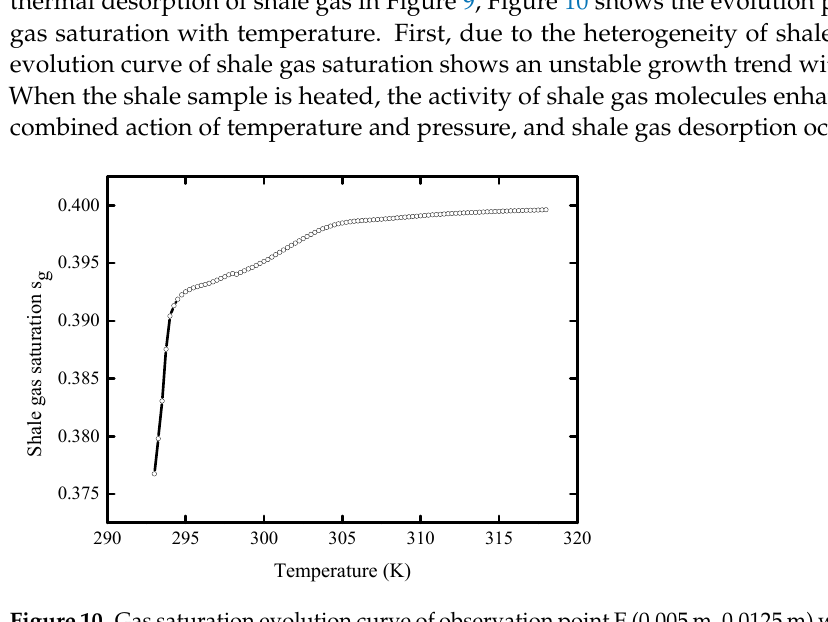
Figure 10. Gas saturation evolution curve of observation point E (0.005 m, 0.0125 m) with tempera ‐ ture.